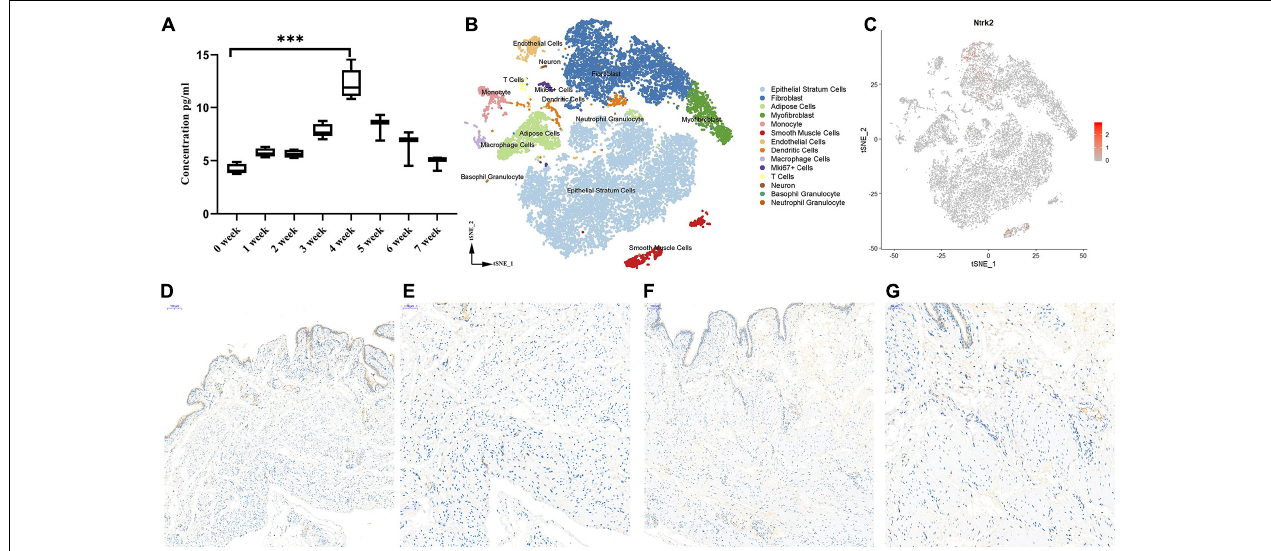
FIGURE 2 | The role of BDNF in the process of PBOO. The level of BDNF in rat serum ( n = 8, female) gradually increase and reach higher levels on 4 weeks, then gradually decrease 4 weeks later (A) . t-SNE analysis of all of the filtered cells ( n = 19,946) from rat bladder (B) . BDNF receptor, Ntrk2 express mainly in interstitial cells and smooth muscle cells ( C , red color). Immunohistochemistry staining of antibody Trkb2 in normal ( D , 10 × and E , 20 × ) and PBOO ( F , 10 × and G , 20 × ) rat bladder. *** P <